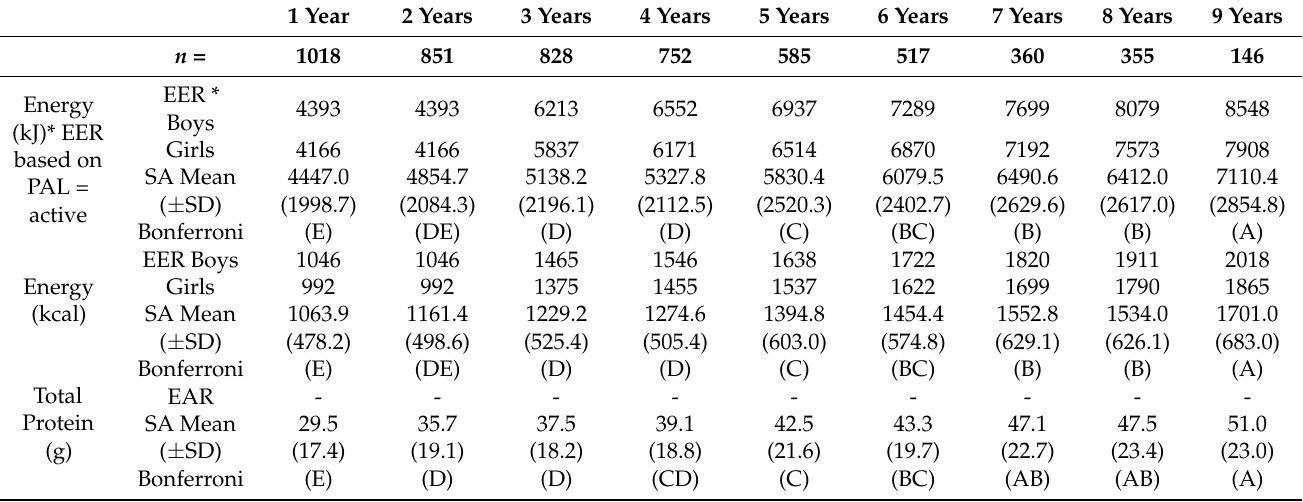
Table 3. South African child mean ± SD intake of energy and macronutrients by year of